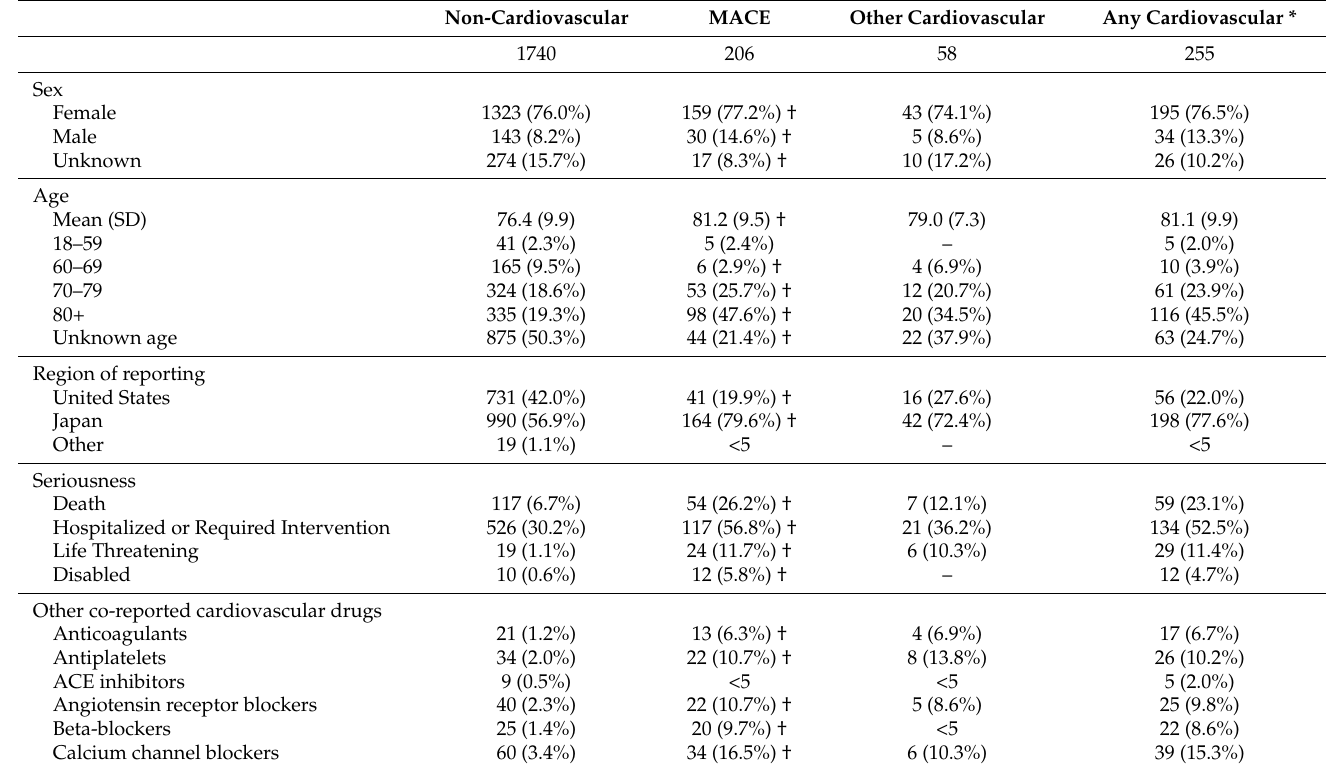
Table 2. Demographic characteristics of case reports with romosozumab ( N = 1995), stratified by cardiovascular